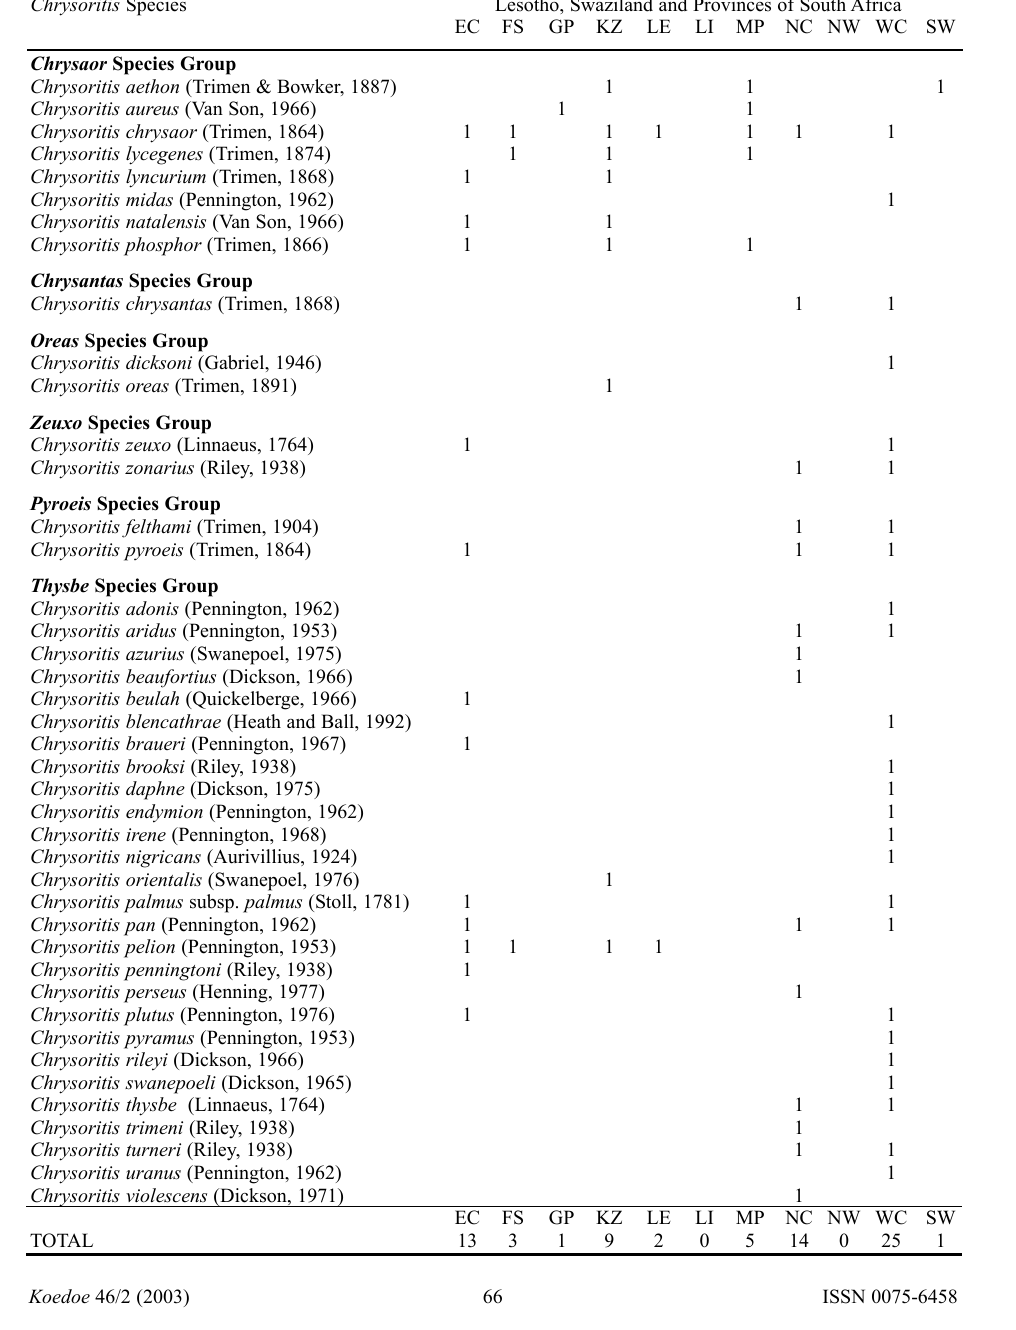
Table 1 The distribution of Chrysoritis species in the provinces of South Africa as well as the Kingdom of Lesotho and Swaziland. A number 1 indicates that the Chrysoritis species occurs in that area. The major regional literature sources used were Clark & Dickson (1971), Terblanche (1991), Keller, Amodio & Stänz (1997), Kloppers & Van Son (1978), Pringle, Henning & Ball (1994), Duke, Saunders & Saunders (1999), and Claassens